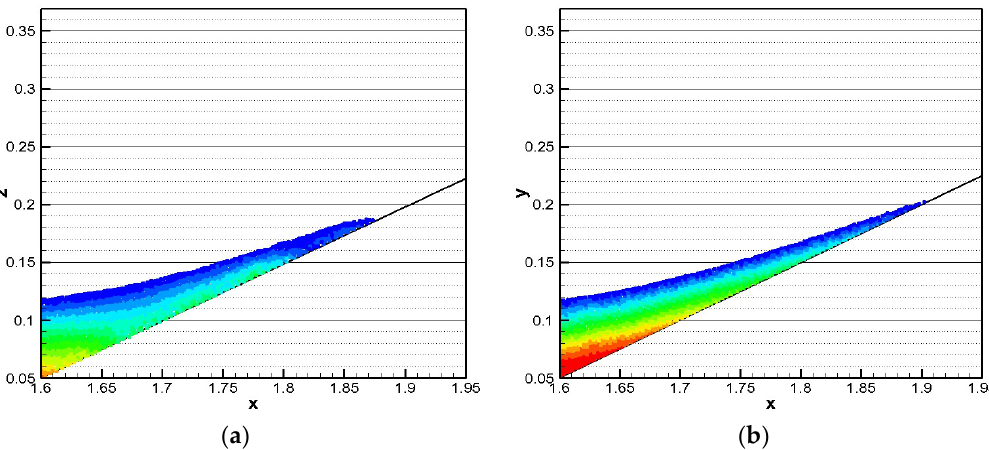
Figure 12. Comparison of wave run-up profile over a slope of 26° in case of H/h = 0.35, simulated by ( a ) fixed- and ( b ) moving-particle wall treatments.